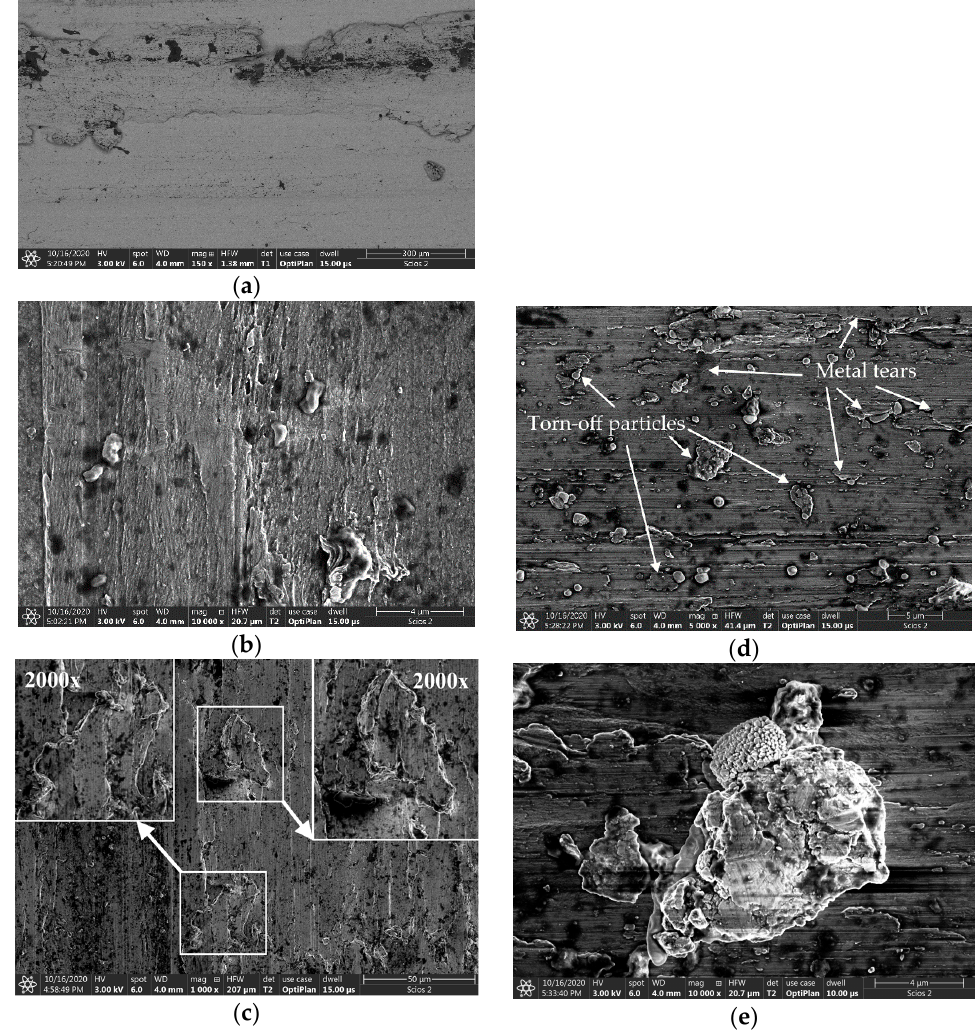
Figure 10. The topography of the wear tracks of the as-fabricated (untreated) BT22 alloy: ( a ) signs of plowing and metal outflows; ( b ) formation of secondary frictional layers on the surface; ( c ) intensive cold plastic deformation and beginning of delamination; ( d ) formation of metal tears and wear particles; ( e ) rolled wear particles